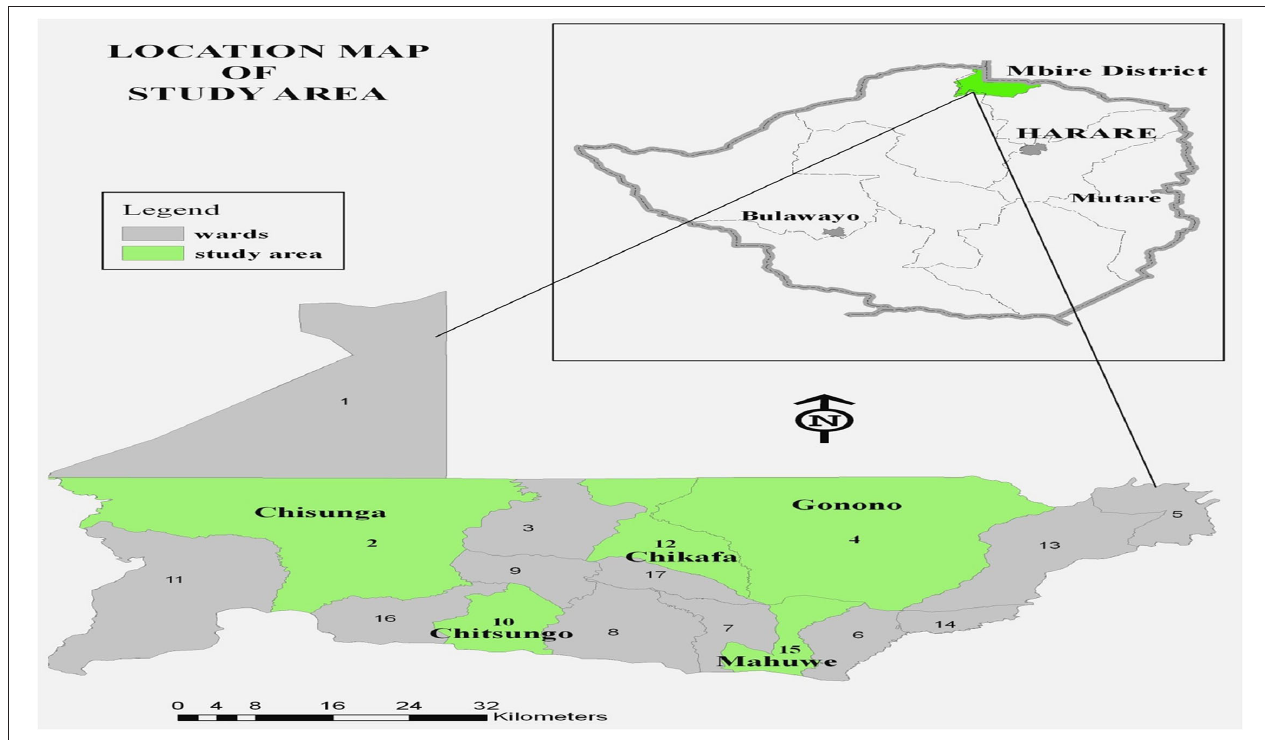
FIGURE 1 | Map showing the study sites.